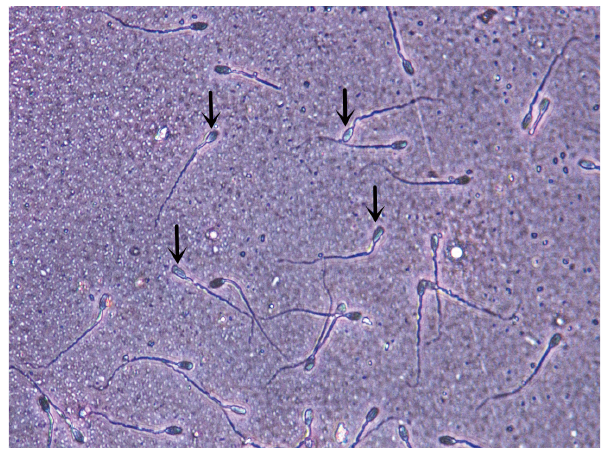
Figure 1. The sperm acrosome integrity image was taken at 144 h, in which the arrow marked sperm is acrosome intact. Sperm acro- some integrity rate were imaged at a magnification of 400× (Hema - toxylin and eosin dyeing).